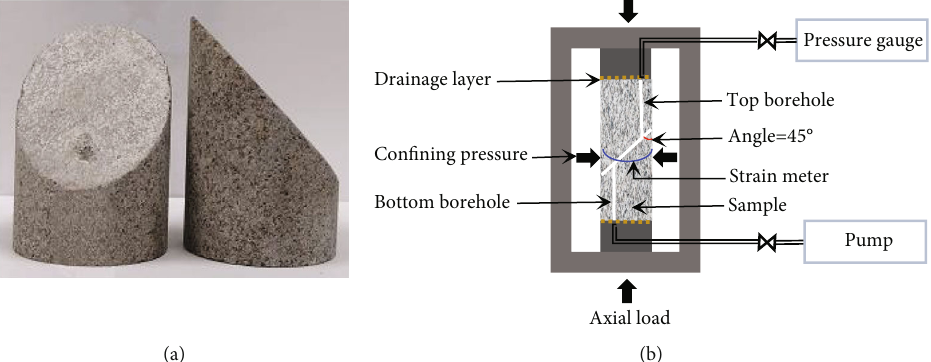
Figure 1: Experimental material and con fi guration. (a) Saw-cut sandstone fracture. (b) Sketch of sample assembly installed inside the triaxial pressure